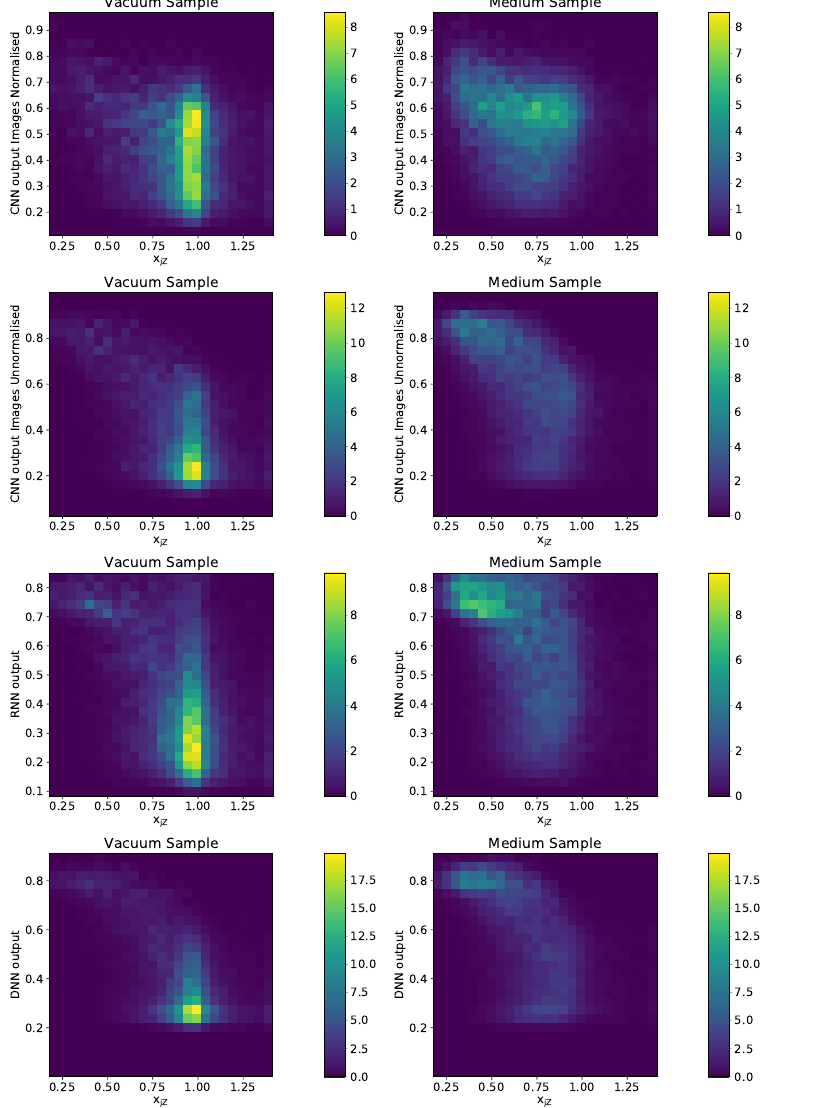
Figure 11 . Distribution of the Deep Learning network output as a function of x jZ for the (left) Vacuum sample and the (right) Medium